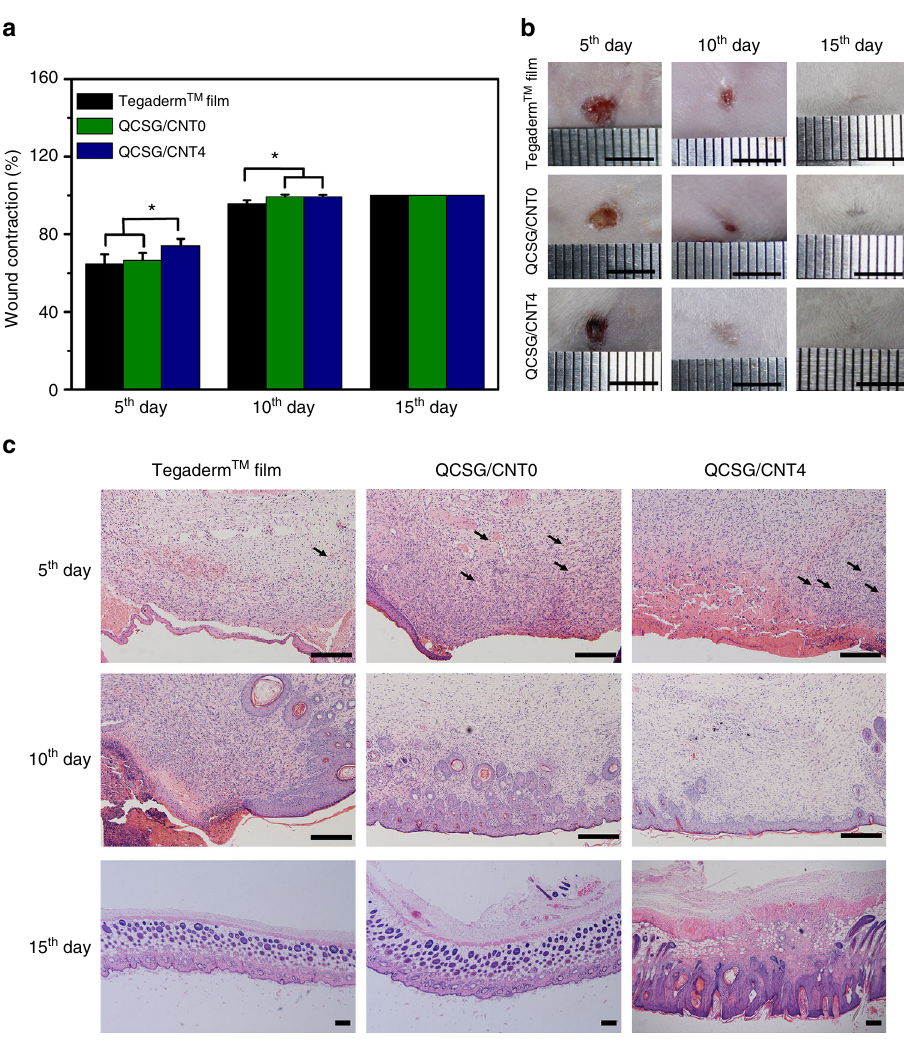
Fig. 8 In vivo wound healing performance of the cryogels. a Wound contraction for Tegaderm TM fi lm, QCSG/CNT0 and QCSG/CNT4. b Photographs of wounds at 5th, 10th, and 15th day for Tegaderm TM fi lm, QCSG/CNT0 and QCSG/CNT4. Scale bar: 5 mm. c Histomorphological evaluation of wound regeneration for Tegaderm TM fi lm, QCSG/CNT0 and QCSG/CNT4 at 5th, 10th, and 15th day. Smooth and complete epithelium layer was presented in two cryogel groups at 10th day, differing from the wound sites in Tegaderm ™ group whose epithelium layer was still incomplete and rough. The wounds in QCSG/CNT4 group had a better formation of hair follicles. All wounds were completely healed and characterized with perfect epithelization at 15 th day. * P < 0.05 using Student's t -test (two-sided). Scale bar: 5 mm. Error bar indicates s.e.m. ( n =